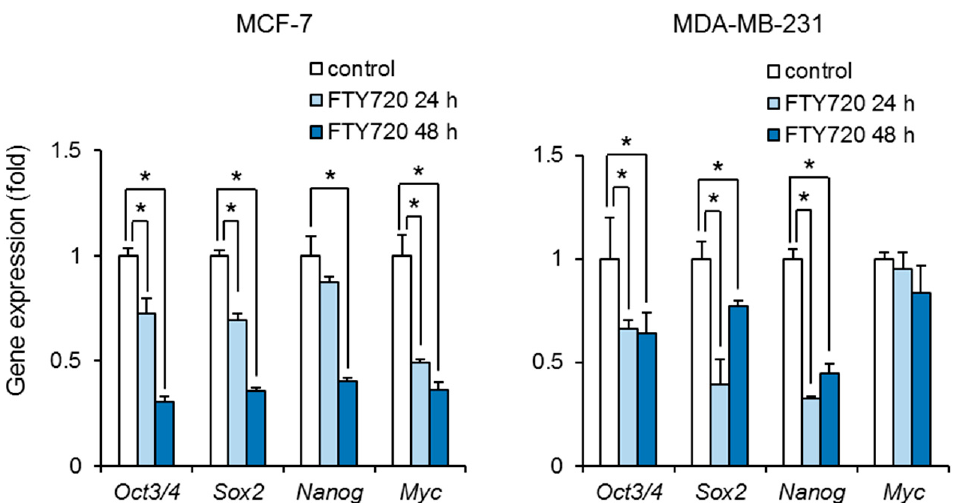
Figure 2. Effect of FTY720 on stem cell marker genes in breast CSCs. After treatment with FTY720 (3 µM) for 24 and 48 h, expression levels of stem cell marker genes in MCF-7 cells ( left ) and MDA- MB-231 cells ( right ) were measured by real-time RT-PCR. Data represent mean ± s.d. ( n = 3). * p < 0.05.